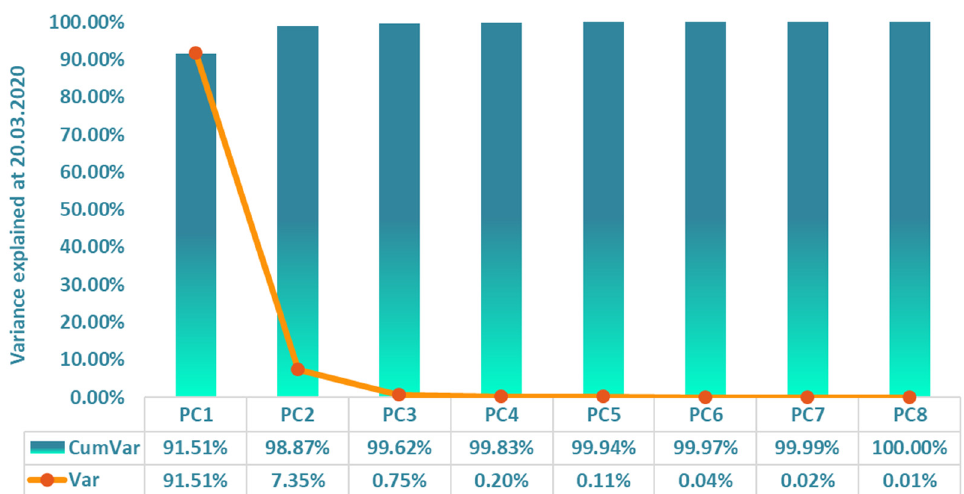
Figure 7. Yield curve variability explained by principal components on 20 March 2020. Source: Bloomberg, own computation of PCs with the use of a VBA add-in developed by Leonardo Volpi.